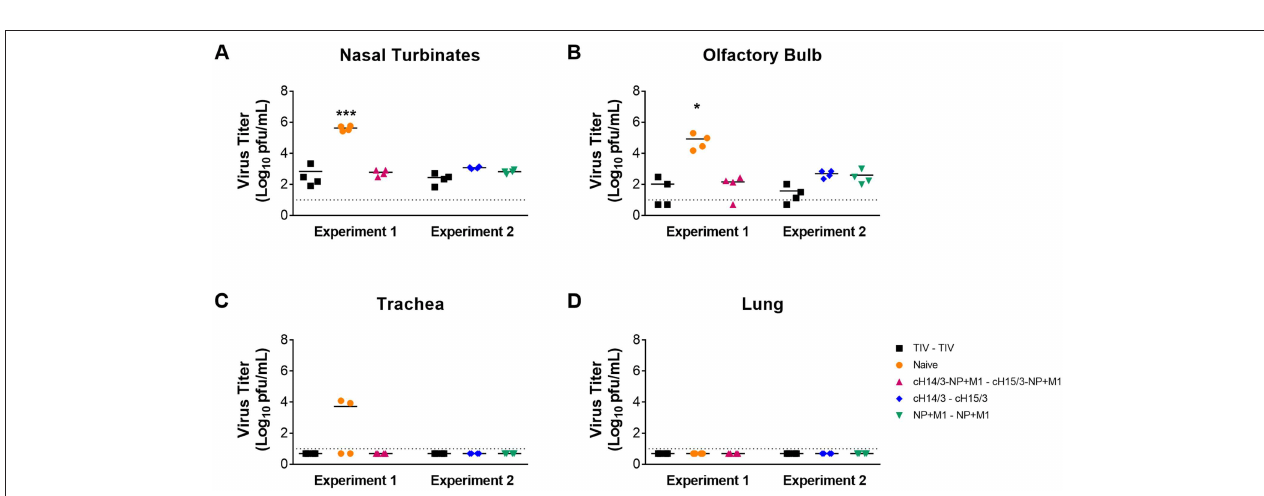
FIGURE 3 | Viral titres in the respiratory tract at day 4 post-challenge. Ferrets were prime-boosted with TIV or viral vectors (ChAdOx1 and MVA) expressing influenza antigens (cHA-NP + M1, cHA, or NP + M1). Six weeks after the boost, ferrets were challenged IN with 10 6 PFU of A/Wyoming/03/2003 (H3N2) virus and at 4 days post-challenge ferrets were euthanized and respiratory tissues were taken to detect virus titres in the nasal turbinates (A) , olfactory bulb (B) , trachea (C) , and lung (D) . The data are presented as individual replicates and the mean for each group is presented as line. n = 4 ferrets/group. * p ≤ 0.05, *** p ≤ 0.001 when naïve controls were compared to individual vaccination groups as determined by one-way analysis of variance, followed by a Bonferroni multiple-comparison test.